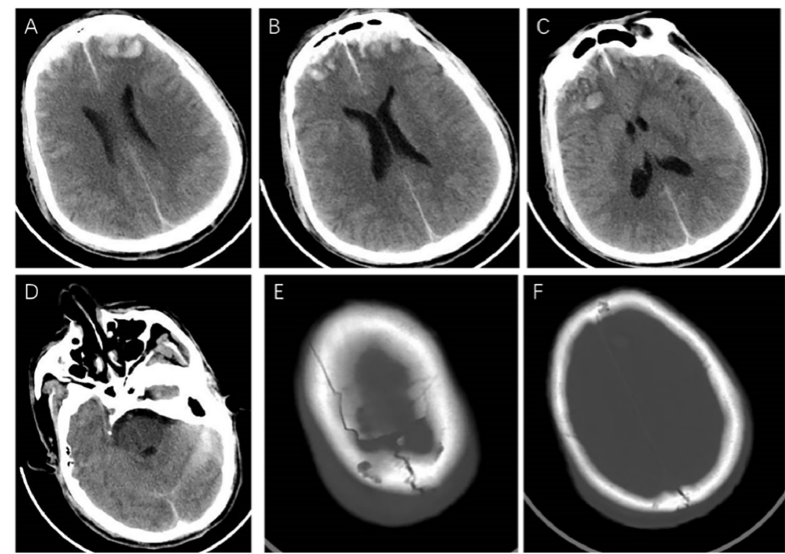
Figure 1. The craniocerebral CT examination on admission. It showed ( A – C ) contusion of bilateral frontal lobe, multiple hematomas in bilateral frontal lobe and right temporal lobe, ( D ) subarachnoid hemorrhage, and ( E , F ) fractures in right frontal bone and bilateral parietal bone.